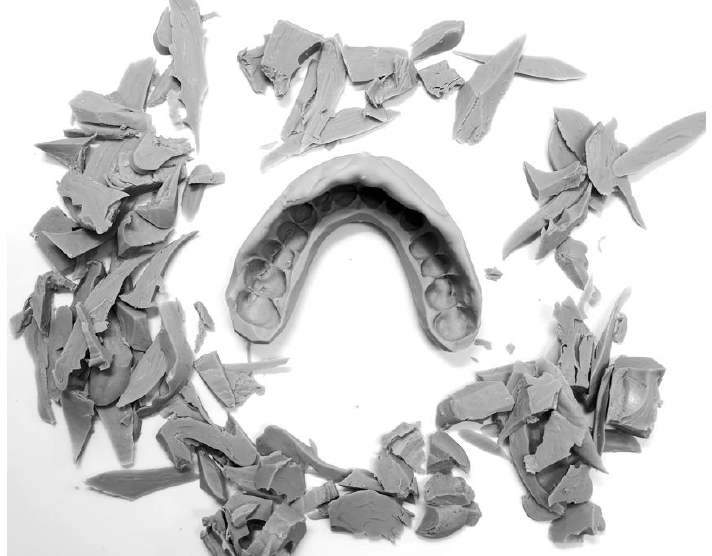
Figure 2. Silicone mouthguard pattern during adjustment using a scalpel.